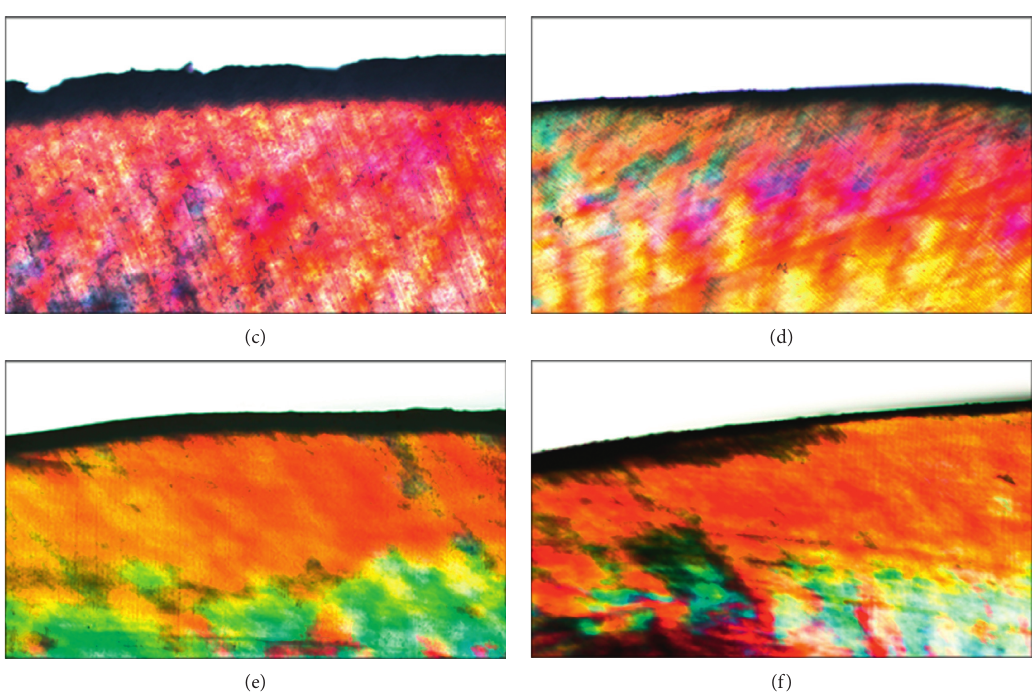
Figure 3: Polarized light micrograph (PLM) at x10 of enamel (a), enamel after artificial formation of demineralization (b), demineralized enamel after application of pH-cycling without remineralization agent (c) and with remineralization agent either nanohydroxyapatite toothpaste (d), or tricalcium phosphate toothpaste (e), or fluoride toothpaste